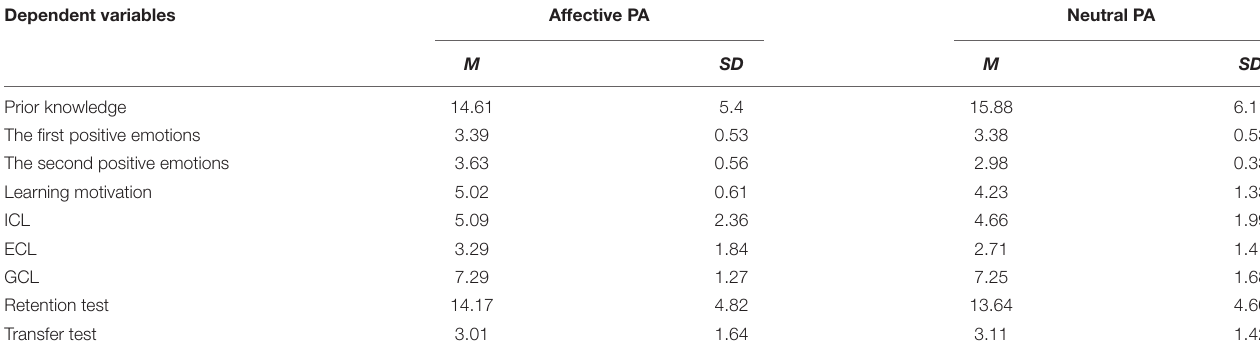
TABLE 1 | Means and standard deviations of all tests for two groups in Experiment